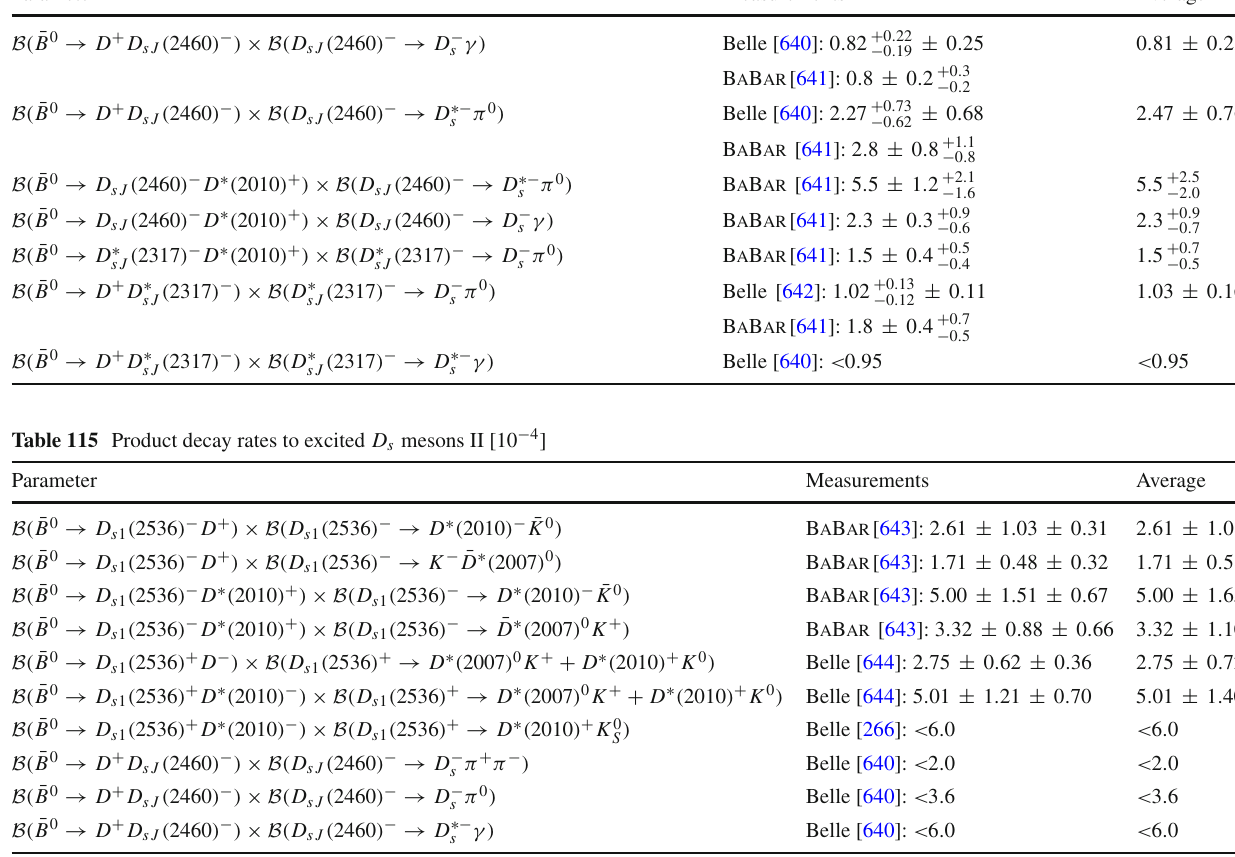
Table 114 Product decay rates to excited D s mesons I [ 10 − 3 ] Parameter